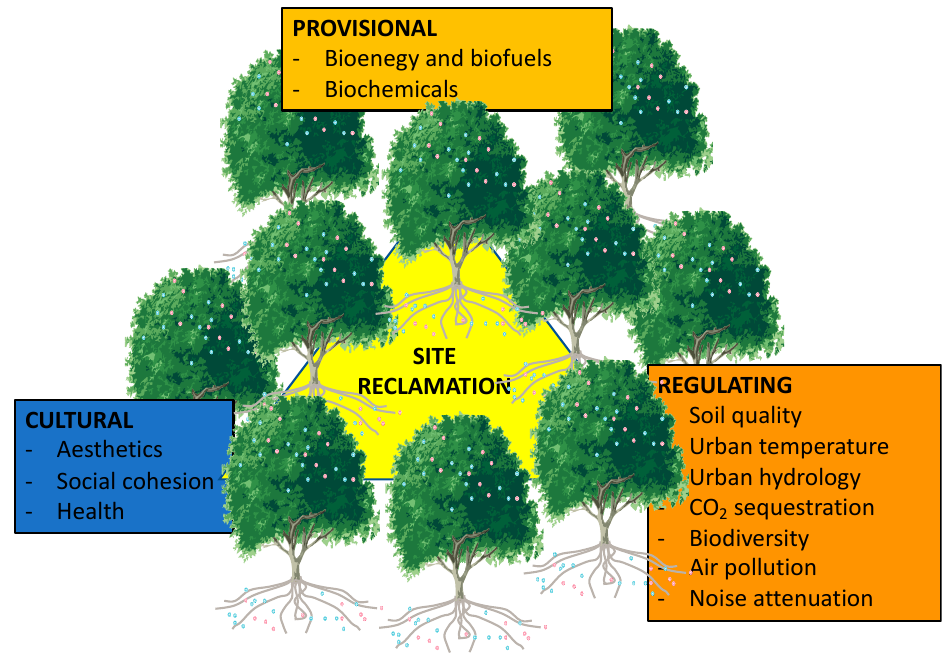
Figure 1. The main components of ecosystem services related to phytomanagement.